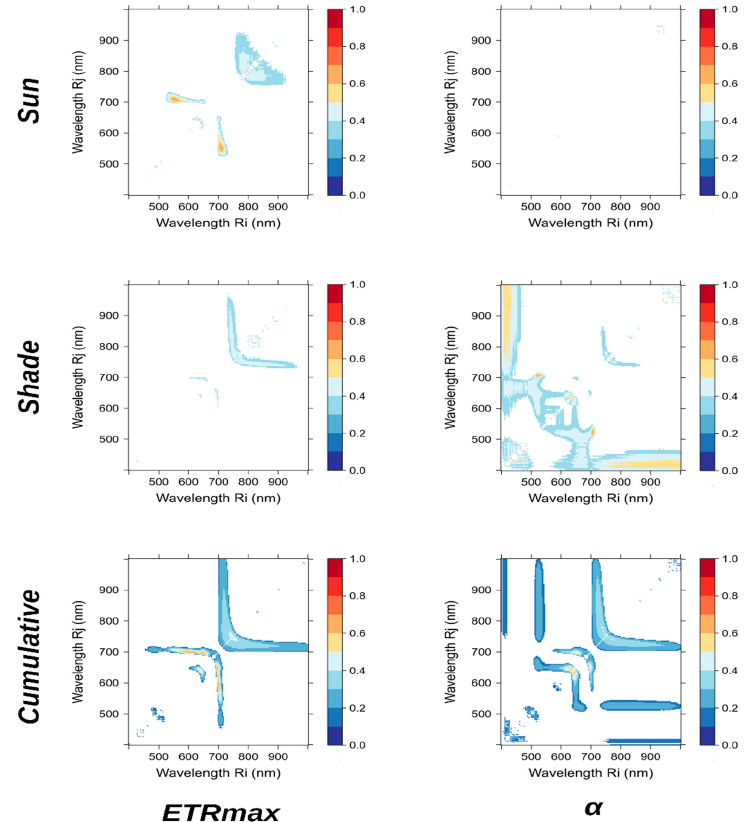
Figure 7. Coefficient of determination (R 2 ) between the two photophysiological parameters (ETRmax (left) and α (right)) and the NDSI (Ri, Rj) measured on Phragmites australis plants at Kerekedi Bay, Lake Balaton on 14–15 August. The NDSI was calculated using the exhaustive combinations of the hyperspectrum of reflectance of two wavebands at i and j. R 2 corresponding to spectral pairs yielding p > 0.05 (statistical insignificant) have been masked out (blank pixels).